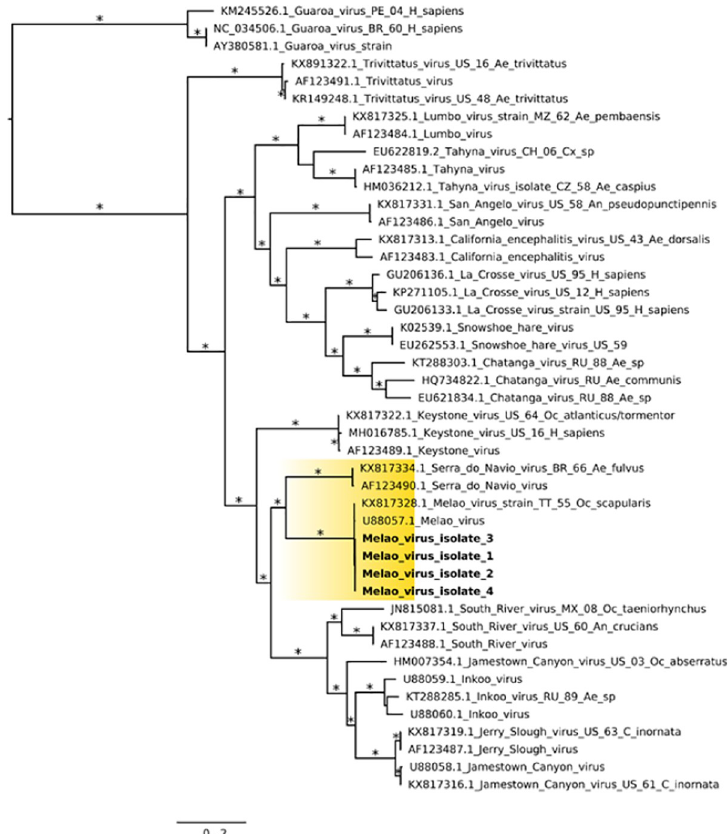
Fig 5. Maximum likelihood tree based on the Medium segment of MELV and other California serogroup orthobunyaviruses isolates. MELV isolates from this study are highlighted in yellow color; GenBank accession numbers for the corresponding small genome sequences are: 1 (MN264271); 2 (MN268723), 3 (MN268726), and 4 (MN268729). Asterisks represents Shimodaira-Hasegawa (SH-like) support values equal or greater than 75%. Branch lengths are drawn in scale of nucleotide substitutions per site according to the bar in the figure. Abbreviations: BR, Brazil; CH, China; CZ, Czech Republic; MX: Mexico; PE, Peru; RU, Russia; TT, Trinidad and Tobago; US, United States. Mosquito genera: Ae ., Aedes; An ., Anopheles; Cx ., Culex; C ., Culiseta; Oc ., Ochlerotatus .